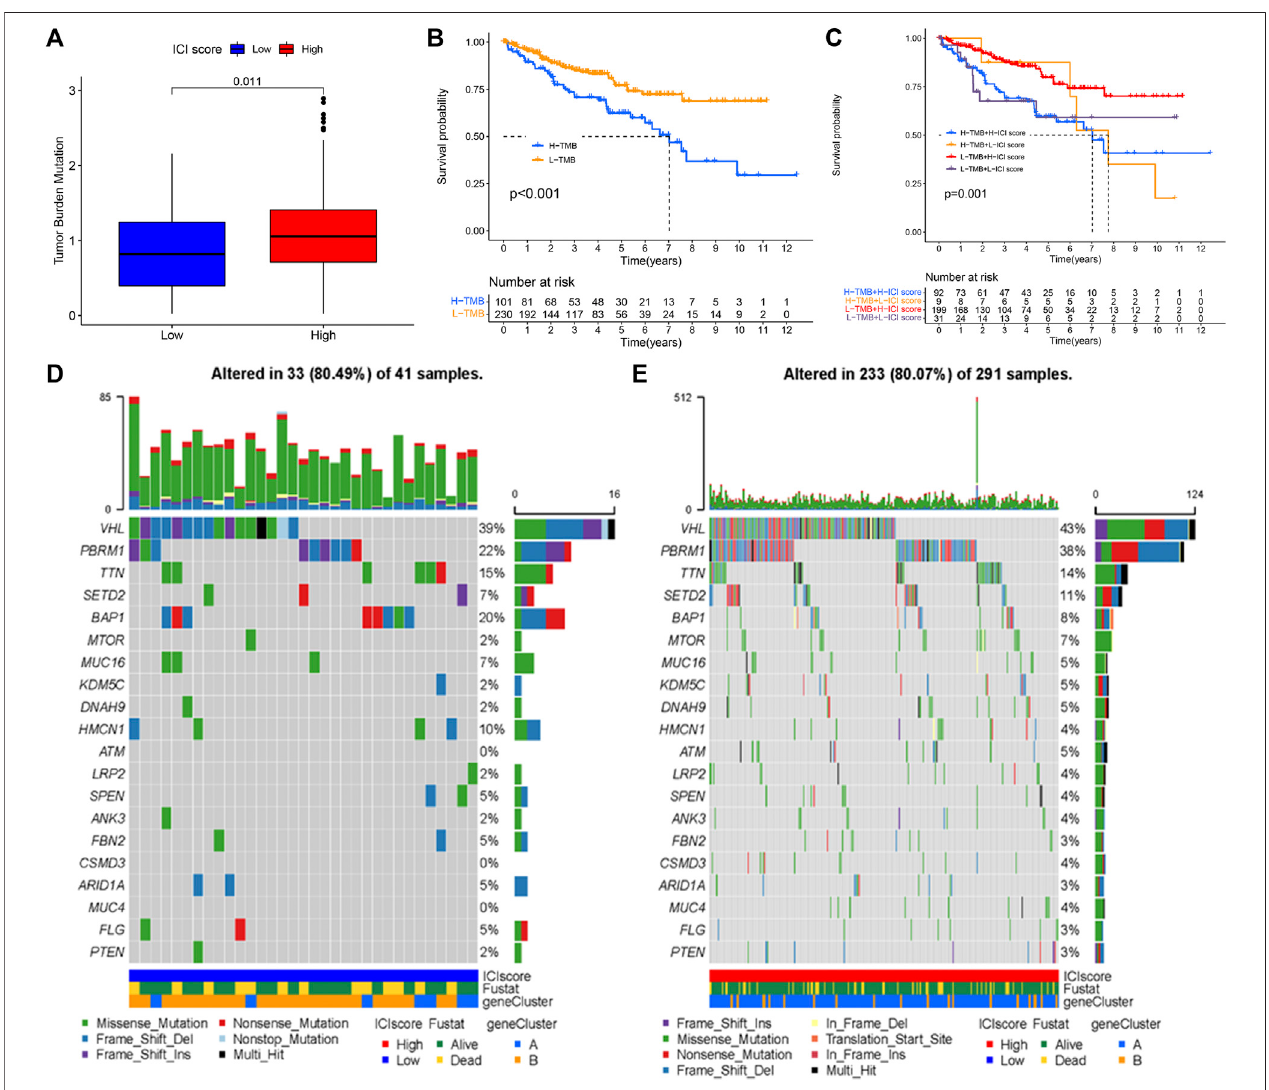
FIGURE 6 | The association of TMB, ICI score, and survival status. (A) The high TMB was related to a high ICI score. (B) Kaplan-Meier curve for low and high TMB subgroupsinKIRCcohort(log-ranktest p < 0.001). (C) Kaplan-Meiercurveanalysisfordifferentsubgroups(log-ranktest p =0.001). (D,E) Thetop20drivergenesinthe low (D) and high (E) ICI score